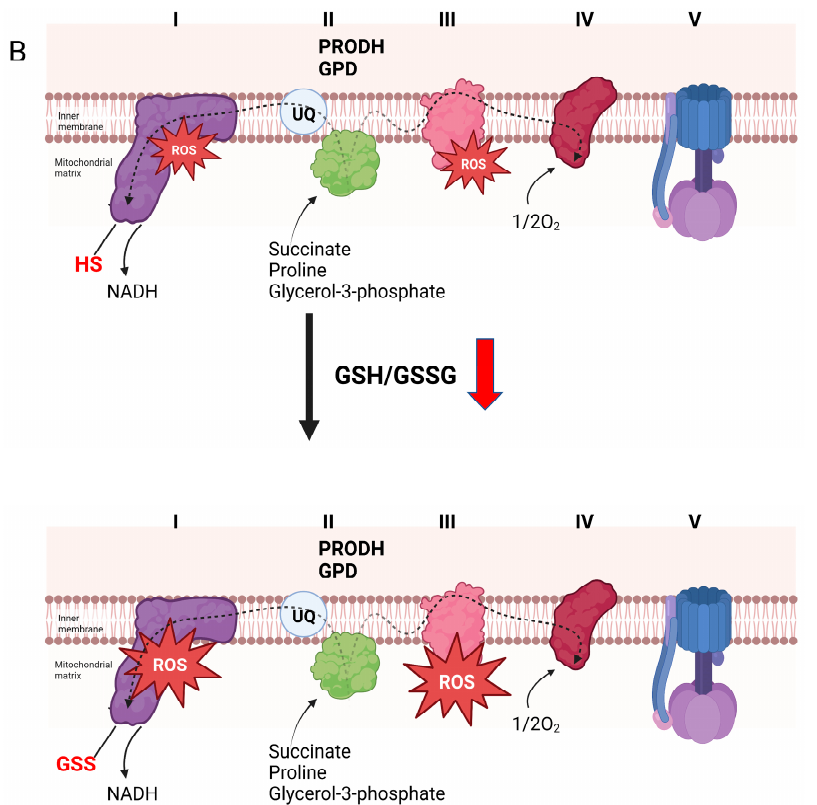
Figure 3. Reversible glutathionylation reactions are integral for controlling the production of H 2 O 2 by complex I and the electron transport chain. ( A ) . Forward electron flow from the Krebs cycle to complex I through the production of NADH (generated by Krebs cycle flux or oxidation of nutrients by non-Krebs cycle enzymes) drives the genesis of both ATP and H 2 O 2 , which is dependent on elec- tron transfer reactions through the respiratory chain. H 2 O 2 is used in mitochondria-to-cell signaling through direct oxidation of protein thiols or oxidation of redox networks (e.g., glutathione and the reversible glutathionylation of cell proteins). Oxidation of the same redox networks feeds back on sites for H 2 O 2 production in the respiratory chain resulting in glutathionylation. This inhibits H 2 O 2 production, decreasing oxidant genesis by mitochondria and promoting the reactivation of mito- chondrial redox networks to maintain antioxidant defenses. This mechanism also desensitizes H 2 O 2 signals emanating from mitochondria during the metabolism of nutrients that generate NADH, which is oxidized by complex I. Blockage of complex I through the glutathionylation of the NDUFS1 subunit inhibits NADH oxidation by preventing electron flow to flavin mononucleotide (FMN), the main site for H 2 O 2 production in complex I. This mechanism for inhibition of oxidant production also prevents H 2 O 2 by sites downstream from complex I, such as complex III. ( B ) . Over oxidation or prolonged oxidation of glutathione pools results in the extended glutathionylation of target proteins in mitochondria. This can result in increased H 2 O 2 production of the respiratory chain. Increased